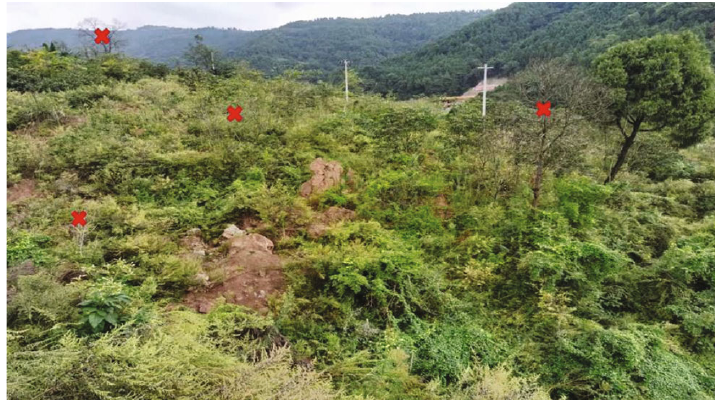
Figure 20: The investigation on vegetation death. X shows the plants have